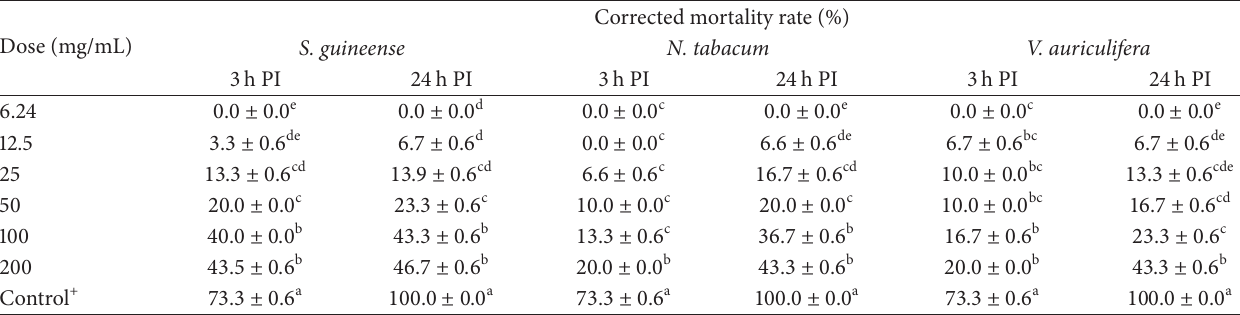
Table 3: Percent corrected mortality of M. ovinus sheep keds exposed to different concentrations of S. guineense , N. tabacum , and V. auriculifera aqueous extracts. Dose (mg/mL)